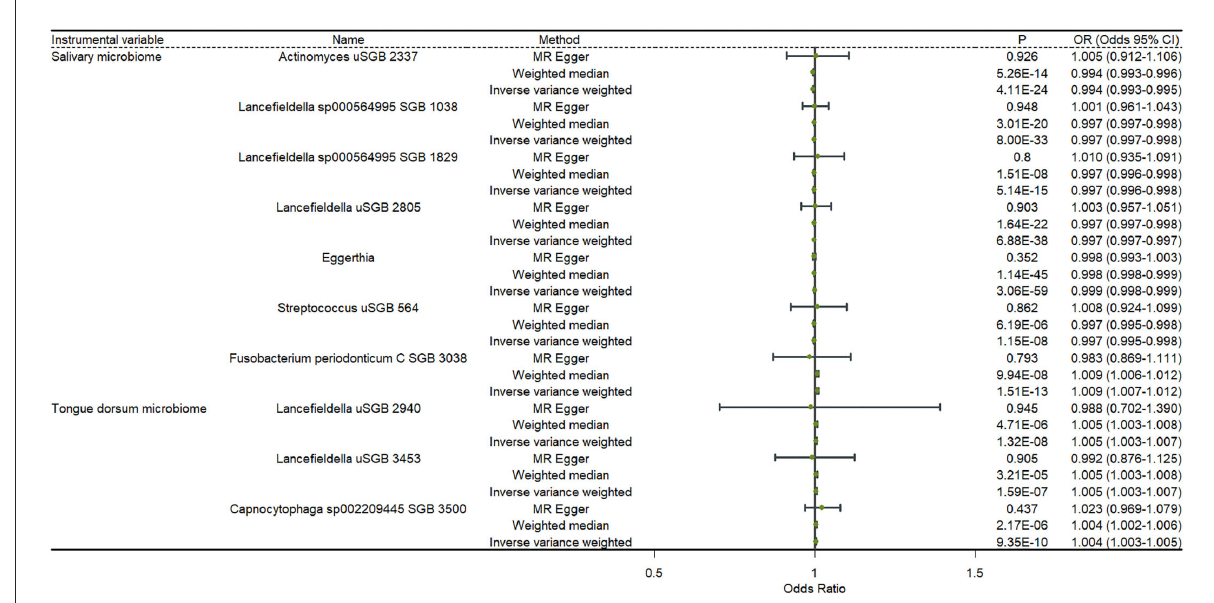
FIGURE3 Causal effects of the oral microbiome on anxiety. Results from inverse-variance weighted (IVW), MR-Egger, and weighted median. Error bars indicate 95% confidence